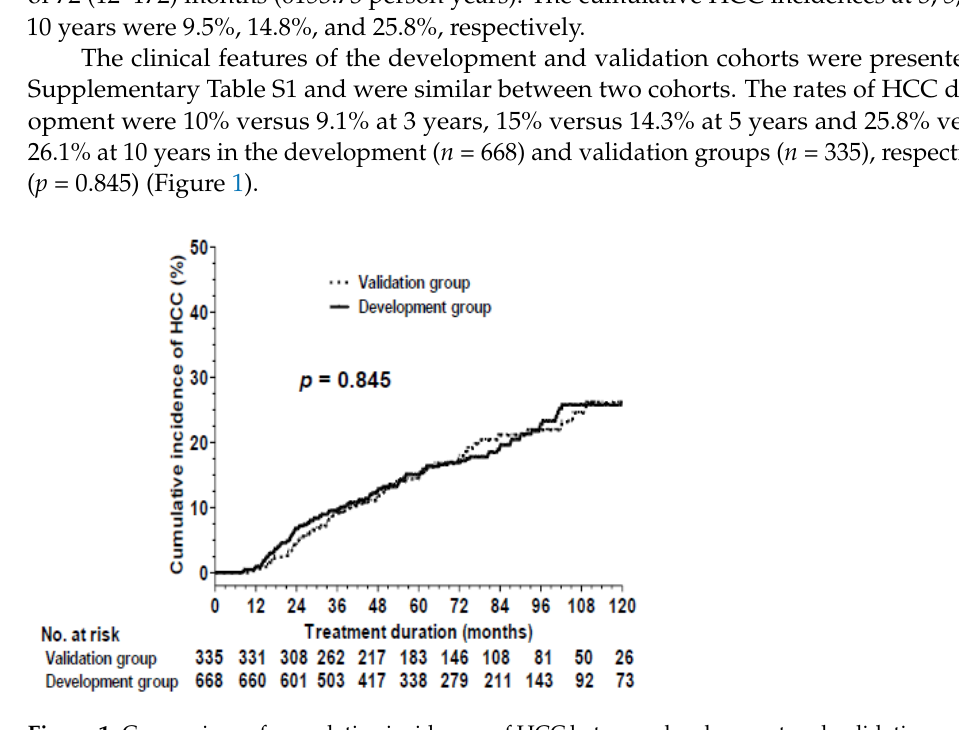
Figure 1. Comparison of cumulative incidences of HCC between development and validation groups.